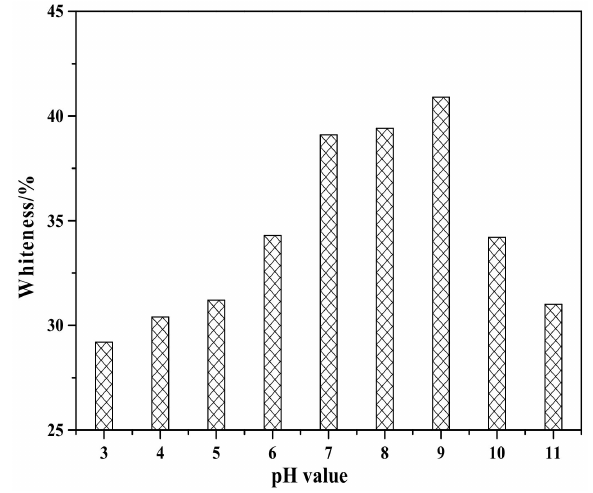
Figure 8. Whiteness of ZCFA powder at di ff erent pH value.